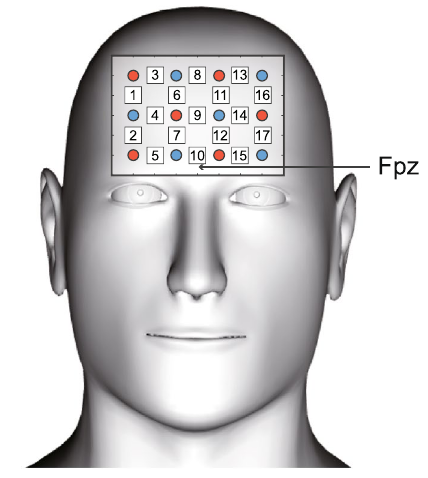
Figure 1. NIRS channel layout. The red circles indicate the emitter probes, and the blue circles indicate the detector probes. Each number indicates the channel